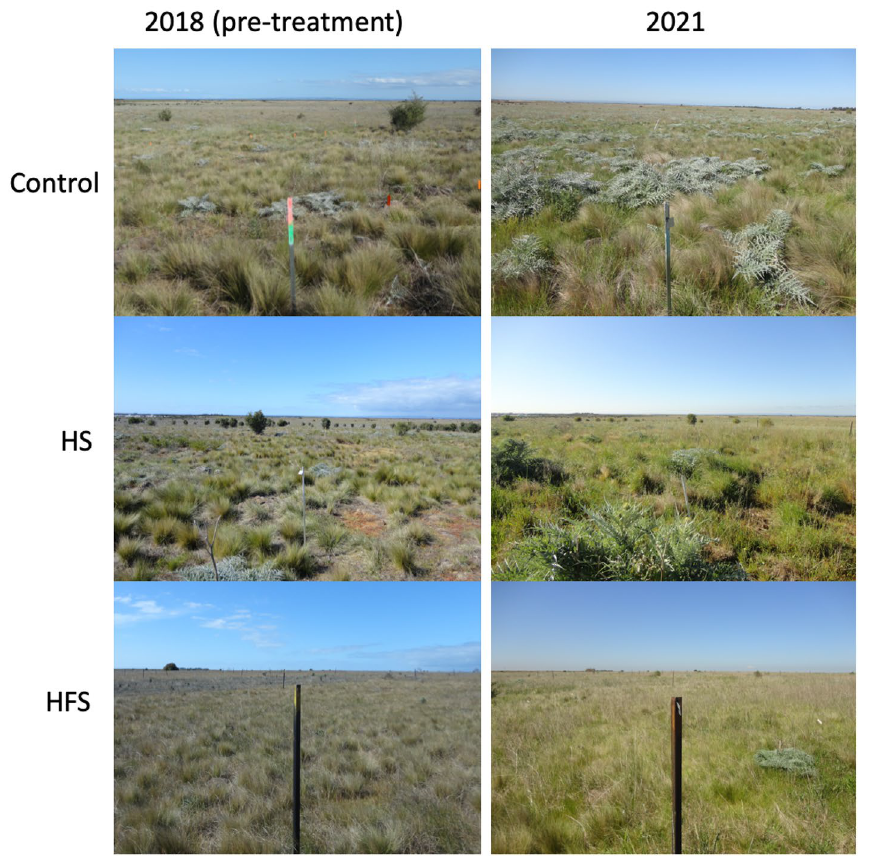
Figure 3. Photographs comparing the same plots at the first sampling period (left) and the fifth sampling period (right) for the HS and the HFS treatments . The control is included as a